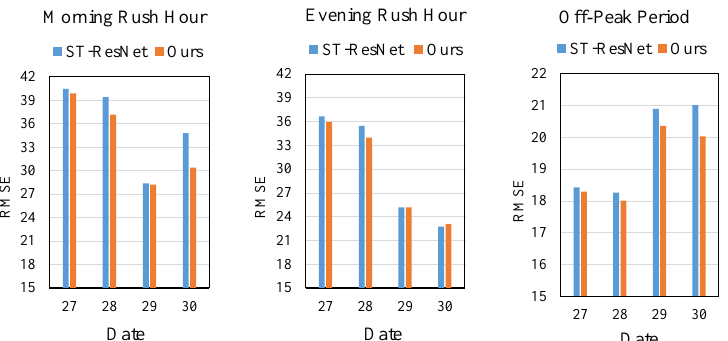
Figure 8. RMSE of different periods between ST-ResNet and our proposed